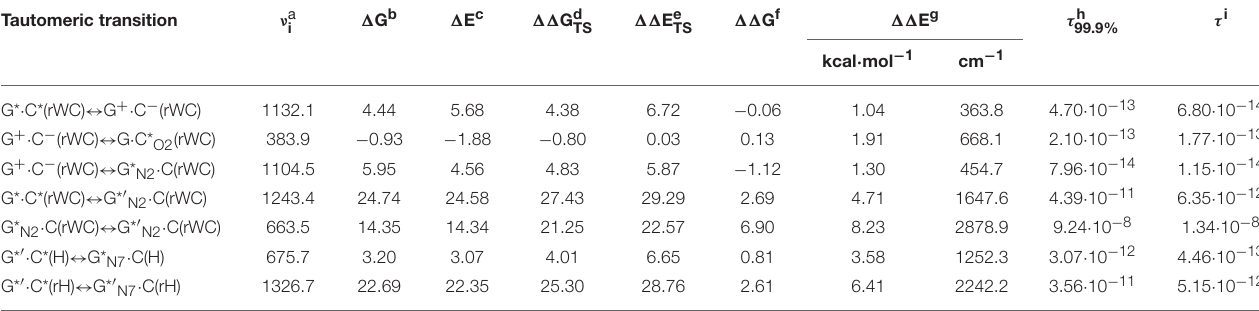
C * (rWC), G * ′ C * (H), and G * ′ C * (rH) DNA base pairs via the SPT or · · · 1 under normal conditions (see Figure 1 ). =